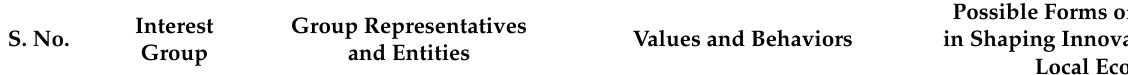
Table 1. University partners in the process of shaping the innovation of the local economy.